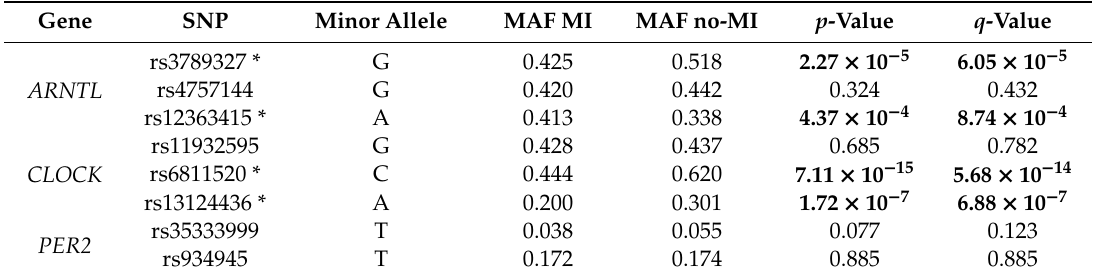
Table 3. Allele frequencies of the ARNTL , CLOCK , and PER2 polymorphisms (N = 1057).